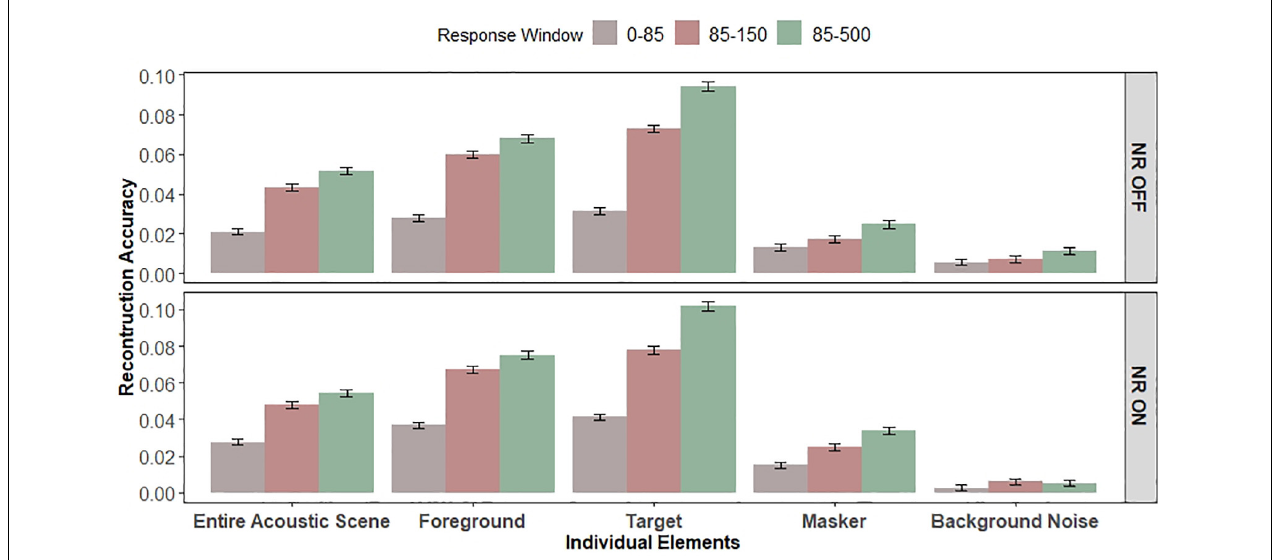
FIGURE 6 | Early vs. late EEG responses. Bar graphs show the average reconstruction accuracy tested for the early (0–85 ms) and late (85–150 and 85–500 ms) integration windows. Left and right panel show the reconstruction accuracy for “NR OFF” and “NR ON” conditions, respectively. Error bars indicate SEM. Significant main effects of EEG response window, NR and individual elements (envelopes) and significant interaction between the response window and individual elements and between the NR and individual envelope were observed. Significant effect of attention (target vs. masker) on early and late EEG responses was observed.